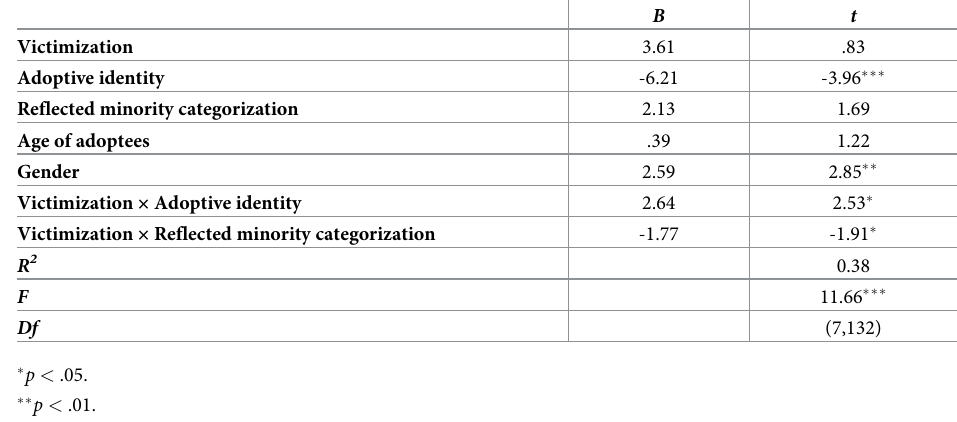
Table 2. Hierarchical regressions testing the model proposed for adoptees’ emotional and behavioral difficulties ( N = 140).